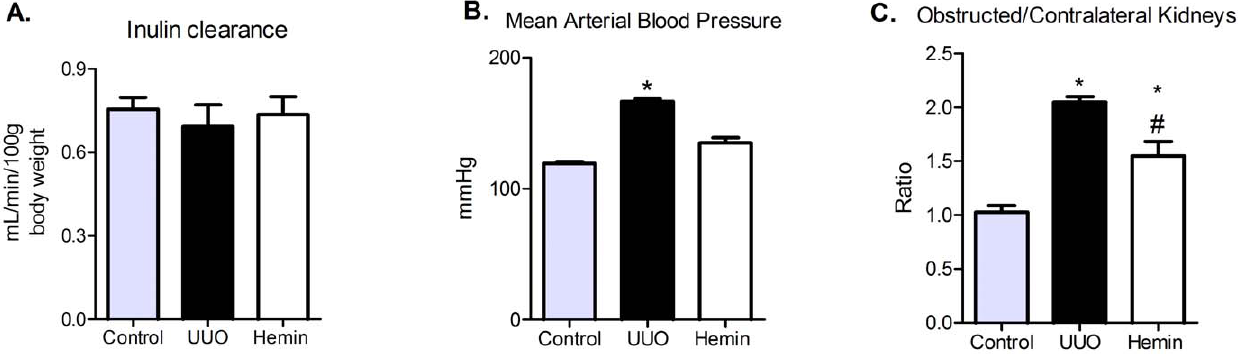
Figure 2. Influence of Hemin treatment on inulin clearance, mean arterial blood pressure and kidneys weight. (A) Inulin clearance was estimated by 100 g of body weight (average 6 s.e.m.). No difference between the groups were observed. (B) Mean arterial blood pressure were assessed during inulin clearance experiments (average 6 s.e.m.) * p , 0,05 vs Control and Hemin. (C) After sacrifice obstructed and contralateral kidneys were removed and weighed. After, a ratio between the kidneys were performed (average 6 s.e.m.). * p , 0,05 vs Control and # p , 0,05 vs UUO. doi:10.1371/journal.pone.0014298.g002 PLoS ONE |